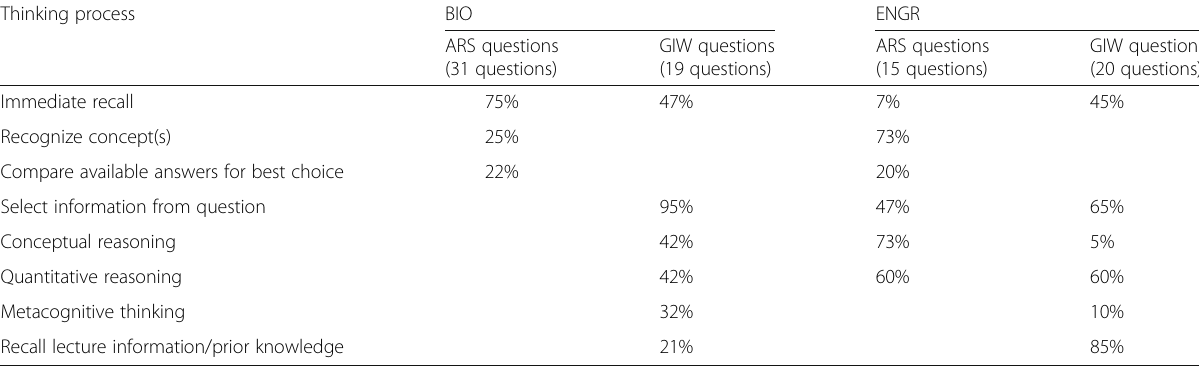
Table 3 Percent of questions identified for coded thinking processes for ARS questions and GIW questions in biology (BIO) and engineering (ENGR) courses. Definitions of codes are presented in Table 1 Thinking